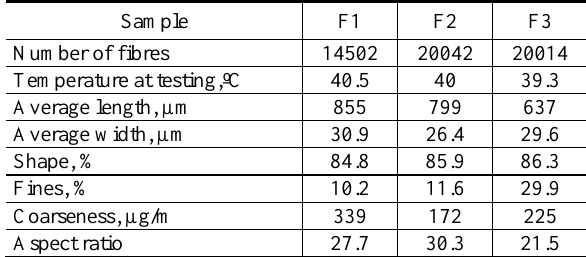
Table 5. Determined fibre parameters. Shape – the ratio of the perceptible to the actual fibre length. Fines – fibers less